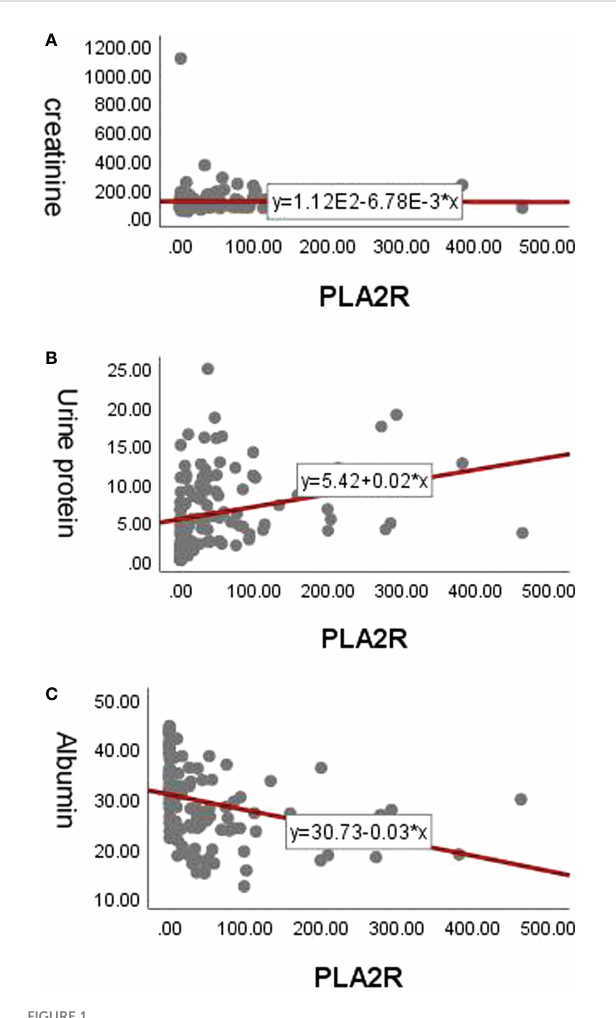
FIGURE 1 Correlation analysis of PLA2R antibody titers. (A) The correlation between anti-PLA2R antibody titers and serum creatinine in the refrectory/relapsed group. (B) The correlation between anti-PLA2R antibody titers and 24-hour urine protein in the refrectory/relapsed group. (C) The correlation between anti-PLA2R antibody titers and serum albumin in the refrectory/relapsed